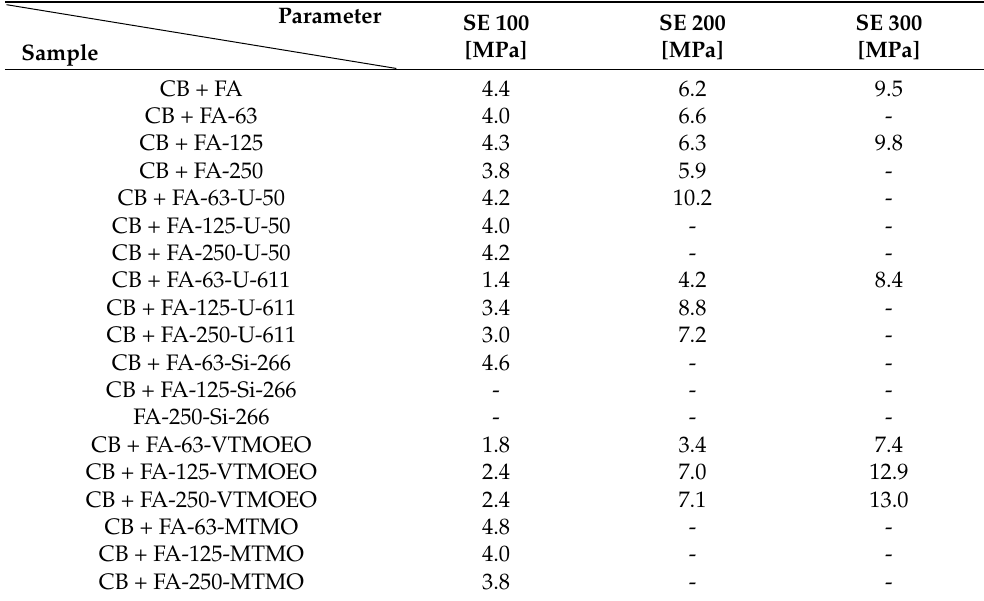
Table 7. Influence of the silanization of fly ash with various silanes on stress at elongation of 100%, 200%, and 300% of the rubber vulcanizates filled with CB and different FA